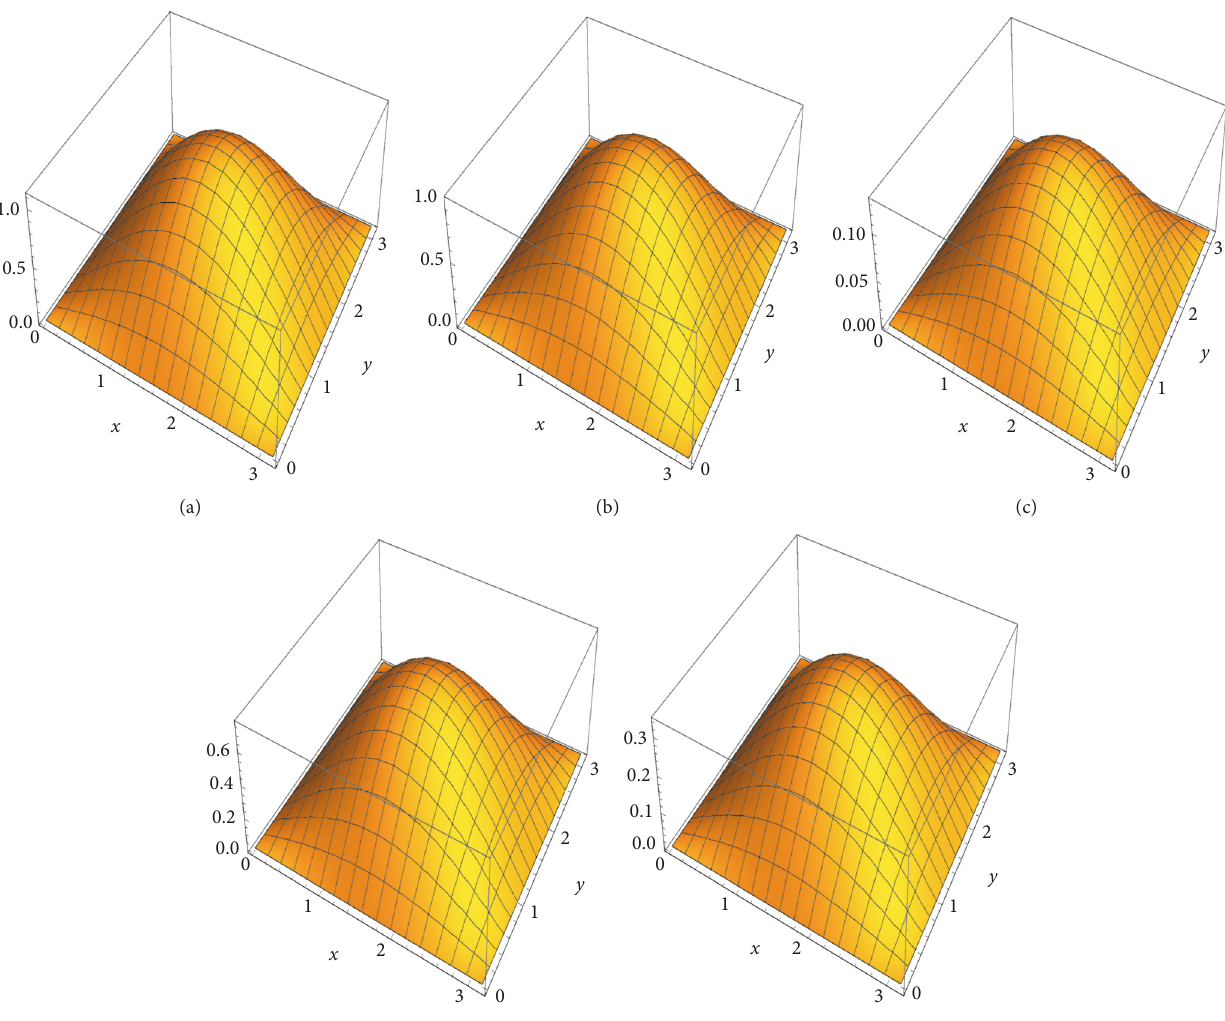
Figure 6: (a) Nonfractional (exact), (b) 𝛼 1 = 0.1,𝛼 2 = 0.4 (3-term FRDTM), (c) absolute error between exact (nonfractional) solution and 3-term FRDTM approximate solution 𝛼 1 = 0.1, 𝛼 2 = 0.4 , (d) 𝛼 1 = 0.8, 𝛼 2 = 1 (3-term FRDTM), and (e) absolute error between exact (nonfractional) solution and 3-term FRDTM approximate solution 𝛼 1 = 0.8,𝛼 2 = 1 .